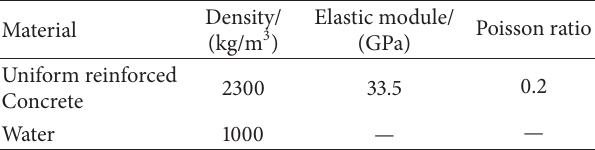
Table 2: The material